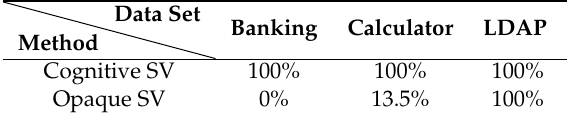
Table 2. Comparison between CSV and Opaque SV accuracies on all three data sets.